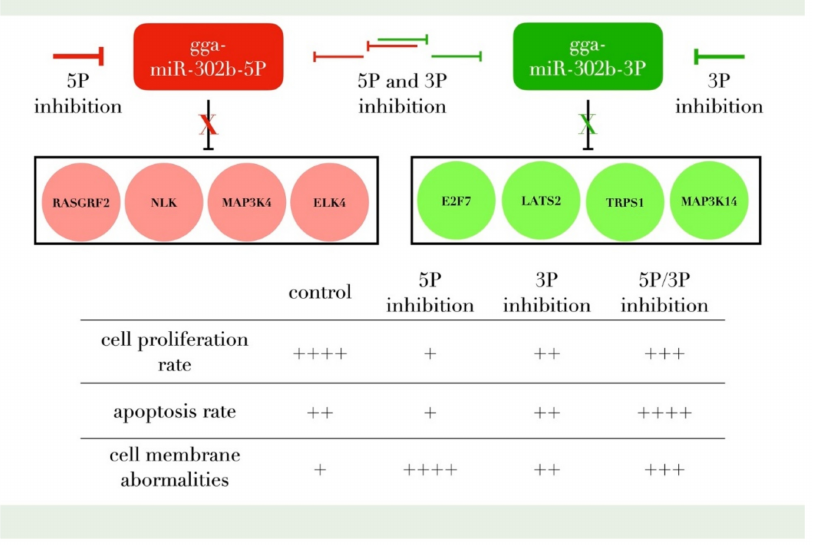
Figure 10. This figure summarizes our findings and the most relevant target genes of gga-miR-302b-5P and gga-miR-302b-3P predicted by the bioinformatic analysis published previously